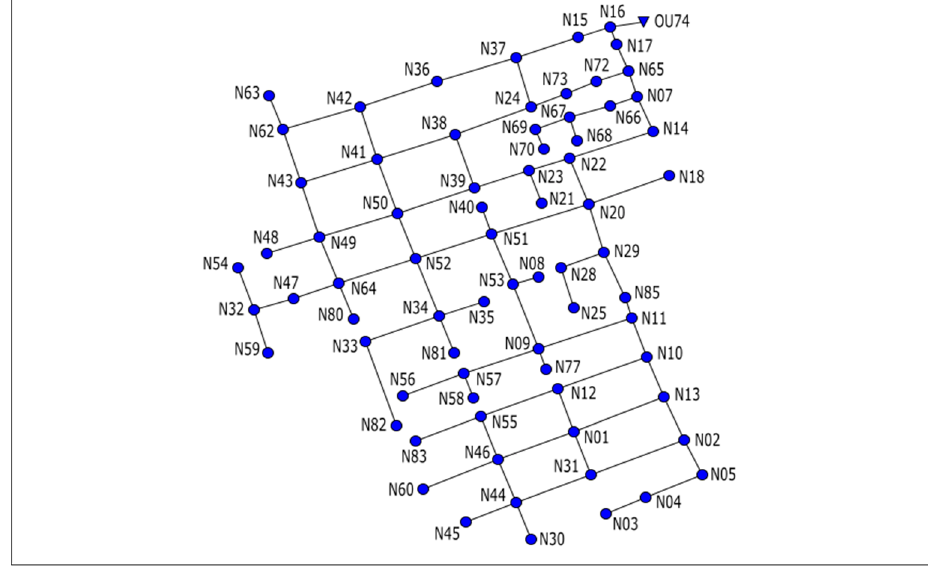
Figure 2. Representation of the Ayurá drainage network.